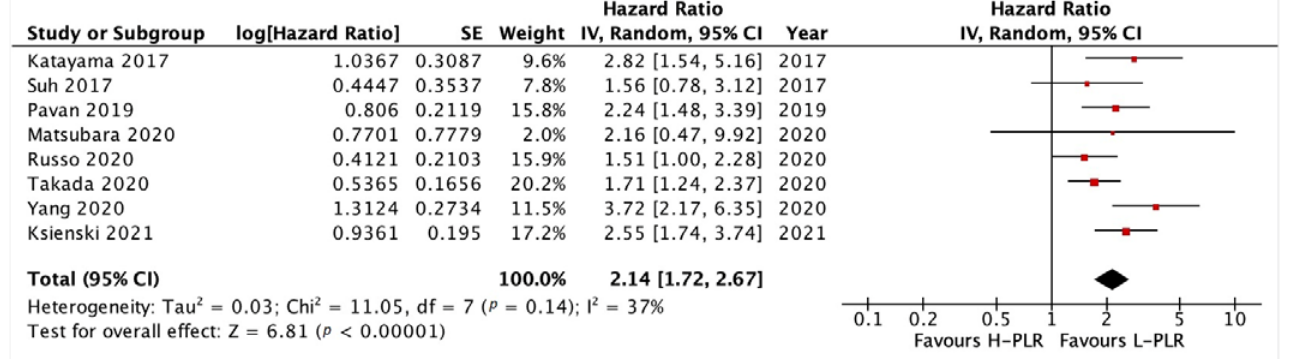
Figure 6. Forest plot H-PLR versus L-PLR to PFS in patients treated with immunotherapy. Red dots represent study weights; the bivalve represent the overall effect.